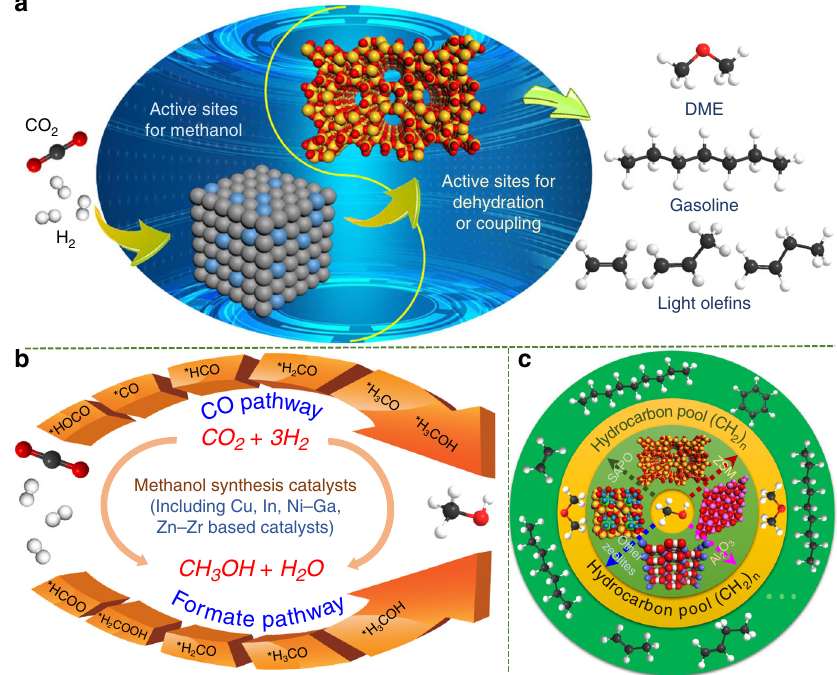
Fig. 1 CO 2 hydrogenation to fuels and chemicals via the methanol reaction mechanism. a Schematic for the reaction mechanism of direct CO 2 hydrogenation to C 2 + products over bifunctional catalysts. b Two possible reaction pathways for methanol synthesis. c Schematic for methanol conversion into hydrocarbons inside zeolites via the hydrocarbon-pool